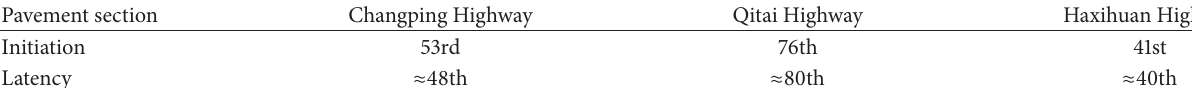
Table 10: Initiation and latency of predicted thermal cracking.